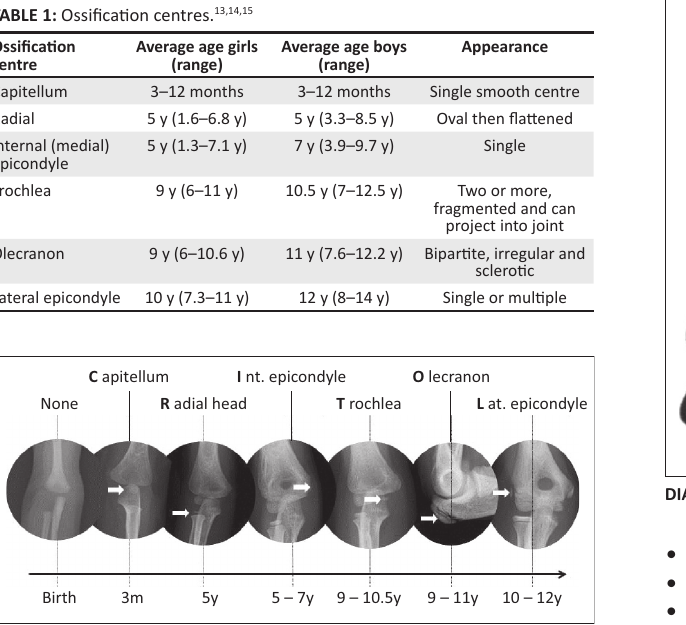
FIGURE 6: Timeline of the appearance of ossification centres.